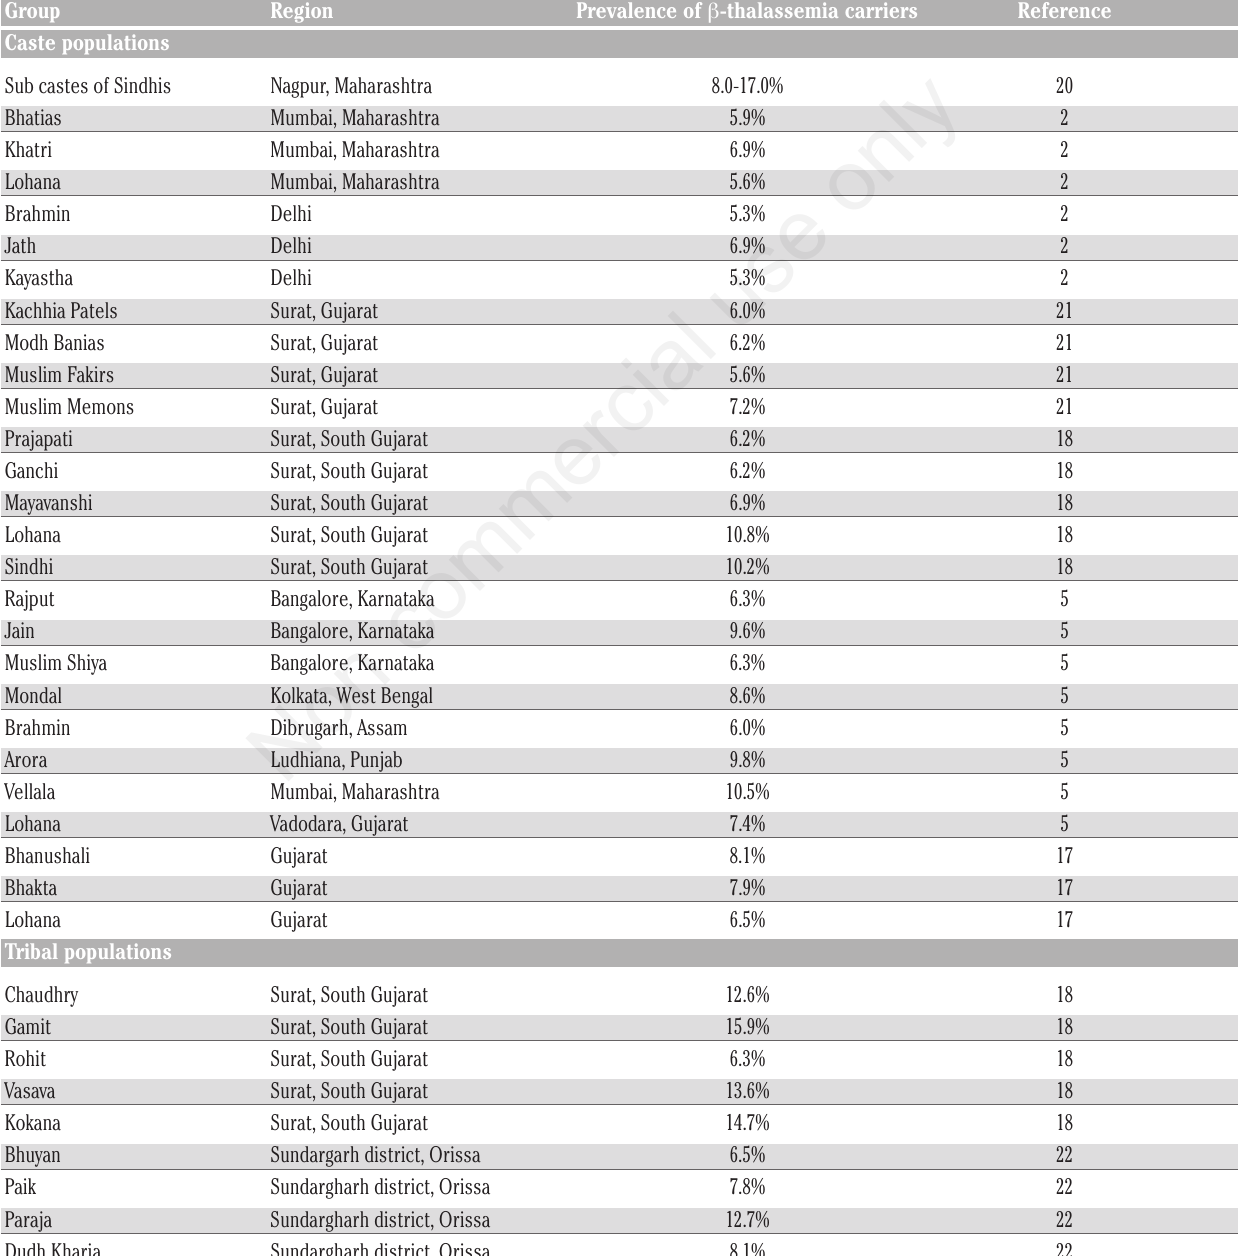
Table 3. Caste and tribal communities with a high prevalence of b -thalassemia carriers. Group